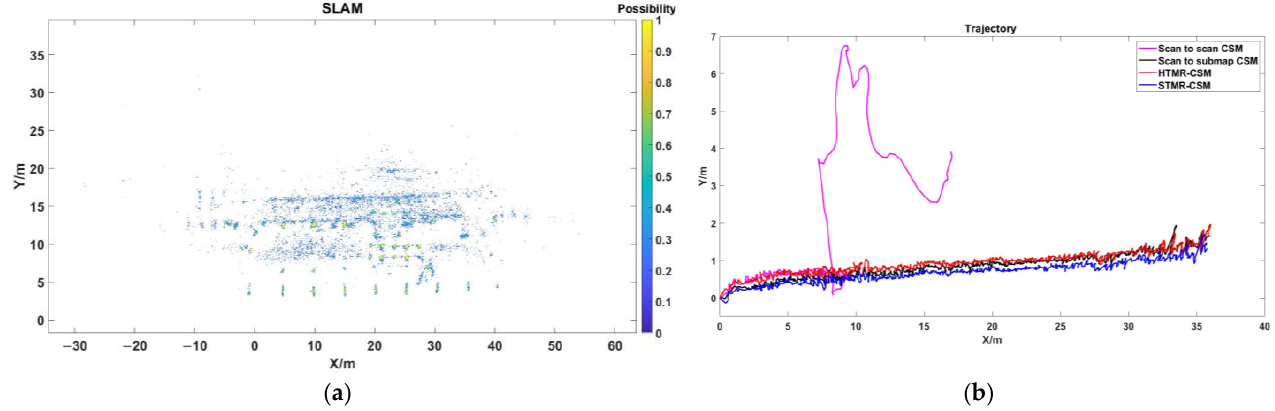
Figure 12. ( a ) SLAM grid map with filtered radar false detections. ( b ) Trajectory comparison.